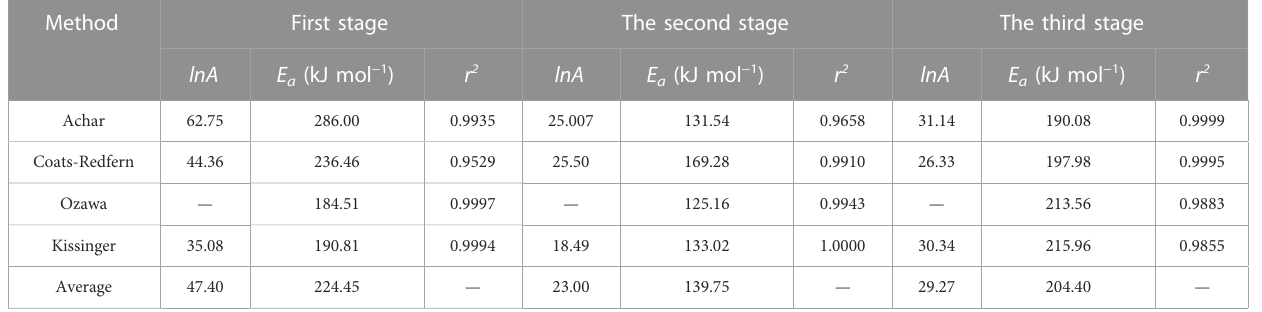
TABLE 6 Thermal decomposition kinetic parameters.